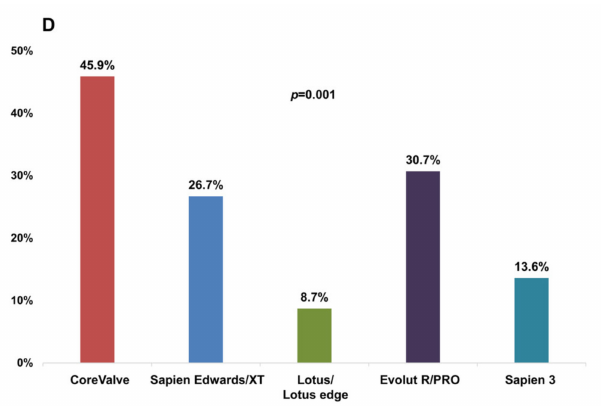
Figure 2. Incidence of significant PVL in each prosthesis group assessed by 1-month follow-up echocardiography. ( A ) early generation versus new-generation valve; ( B ) self-expandable versus balloon / mechanically expandable valve; ( C ) valve without leakage-proof function versus valve with leakage-proof function; ( D ) in the five prosthesis groups. PVL, paravalvular